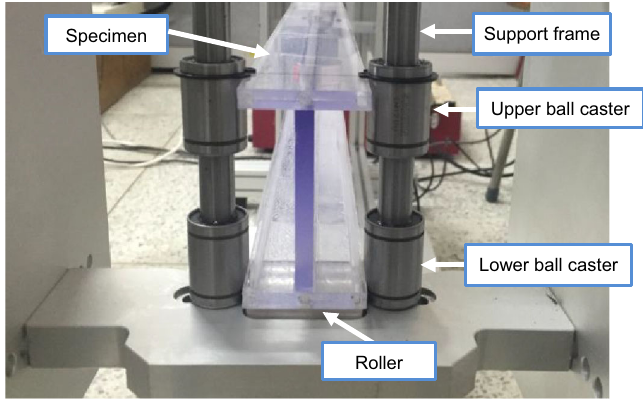
Fig. 2 Strong-axis (in-plane) and weak-axis (out-of-plan)